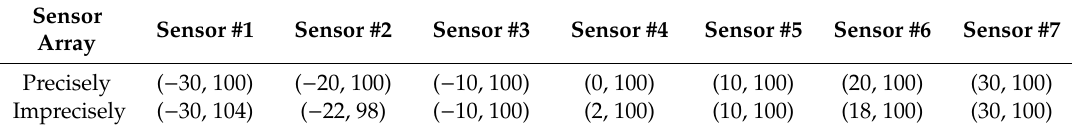
Figure 3. (a) Finite element method (FEM) model with error position of sensor array, (b) excitation Table 1. The coordinates (x, y) of FEM nodes selected for sensor array. signal. Table 1. The coordinates (x, y) of FEM nodes selected for sensor array.